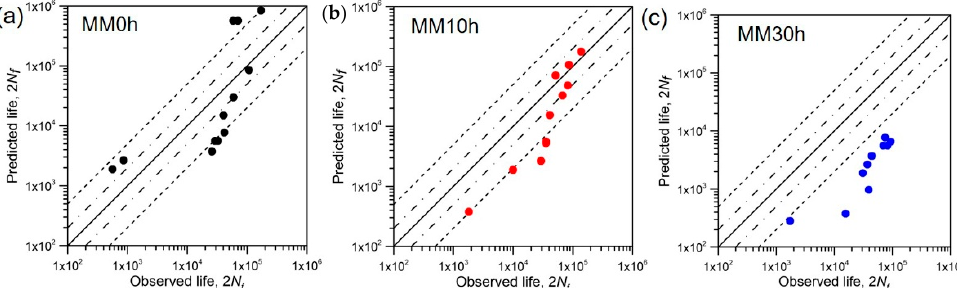
Figure 8. Comparison between observed life and predicted life based on the SWT fatigue-life-prediction model of harmonic-structured SUS316L steels: ( a ) MM0h compacts; ( b ) MM10h compacts; ( c ) MM30h compacts. Table 4. Tensile strength and SWT parameters of harmonic-structured SUS316L steels.